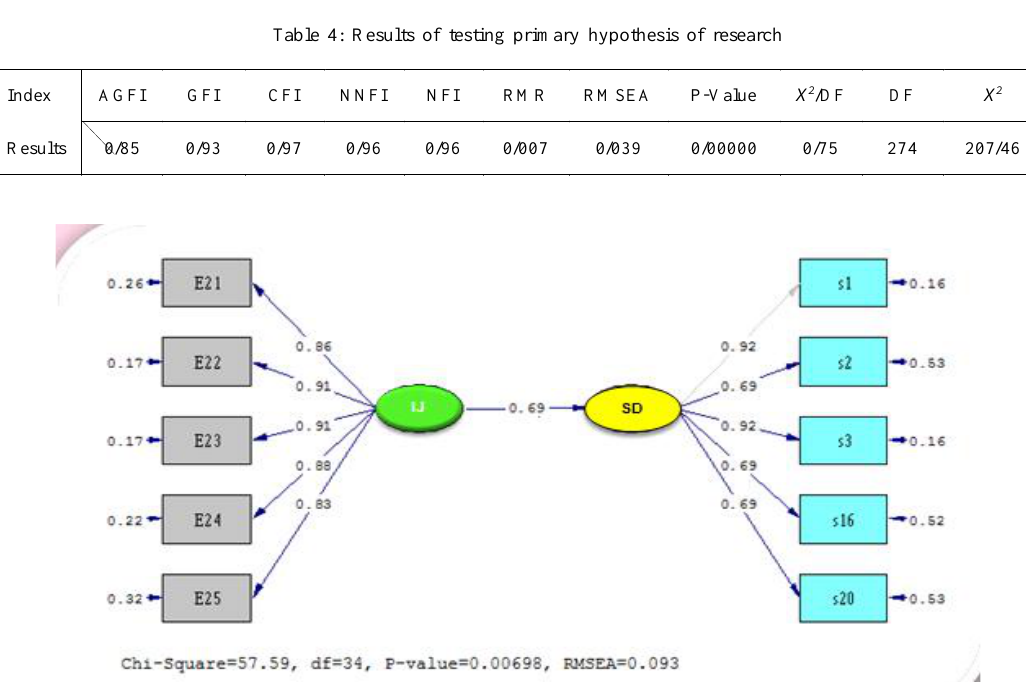
Fig. 4: Confirmatory Factor Analysis of First sub hypothesis of the Research (Standard Estimation